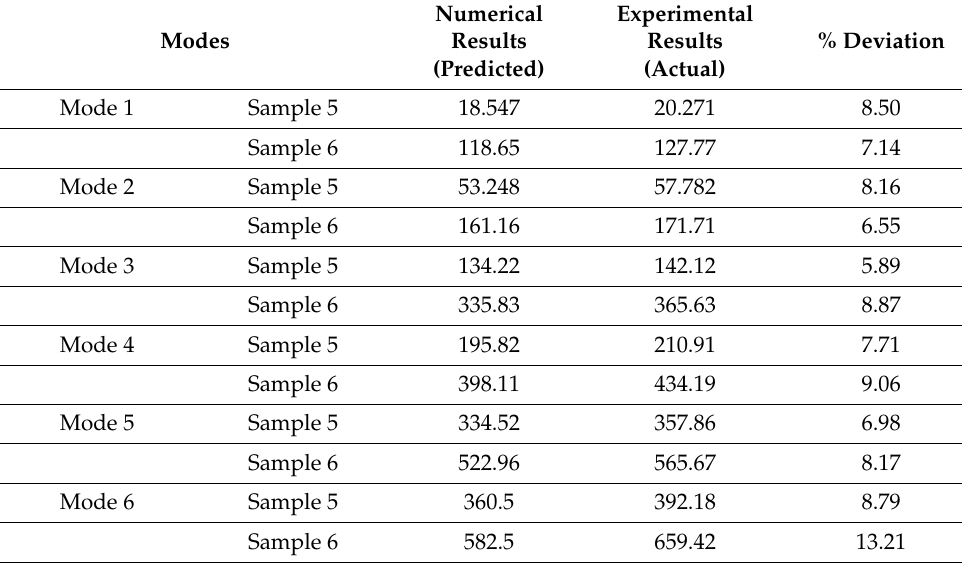
Table 6. Comparison of the experimental and numerical